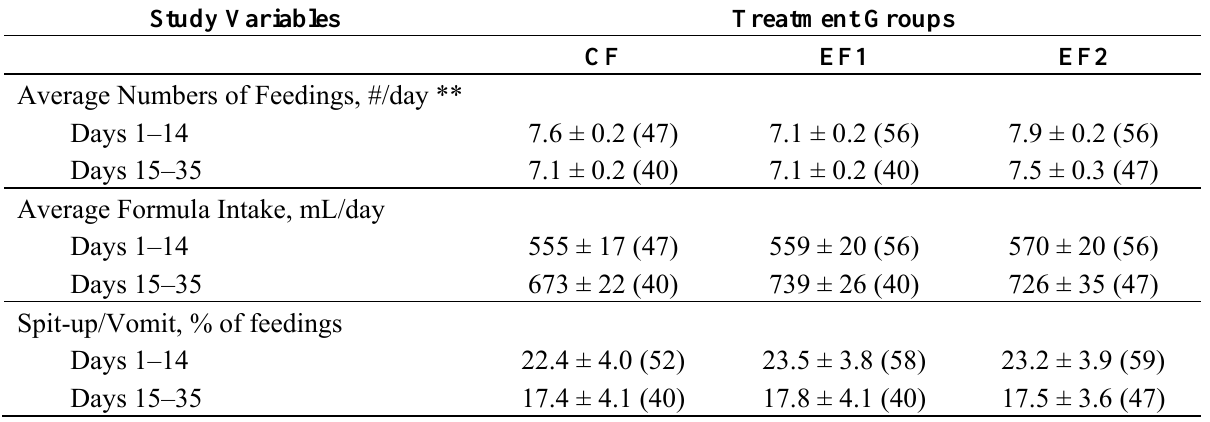
Table 5. Gastrointestinal tolerance of study formulas in evaluable (EV) subjects *.